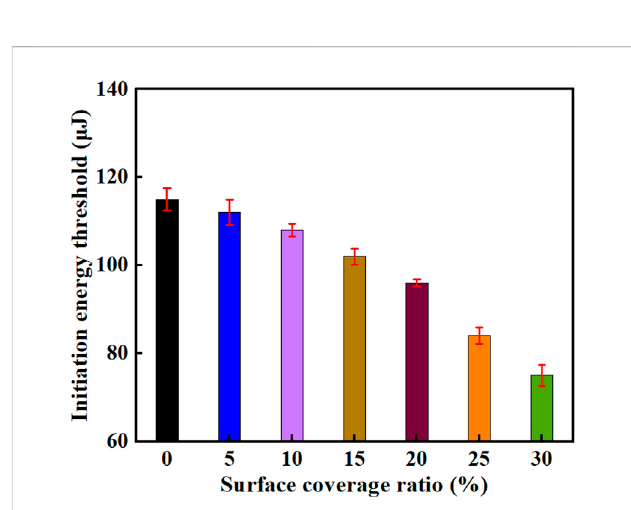
FIGURE 5 The relationship between the initiation energy threshold and surface coverage ratio. Error bars represent standard